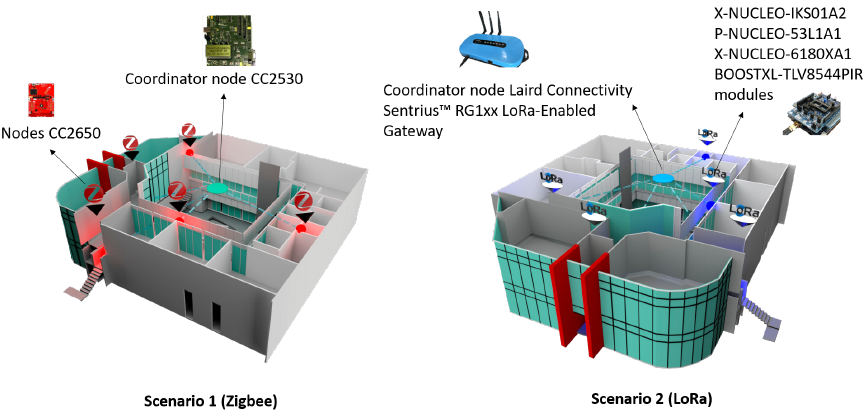
Figure 17. Real network deployment in the engineering area of the